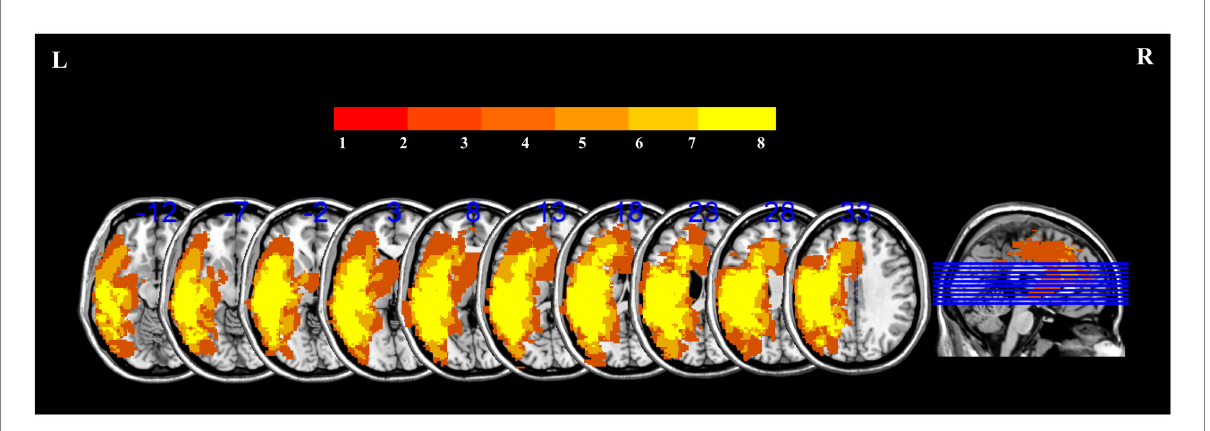
FIGURE 3 Lesion overlap map for 29 patients with PSA to illustrate the distribution of lesions. The color scale in the spectrograms represents the frequency of injury in a given